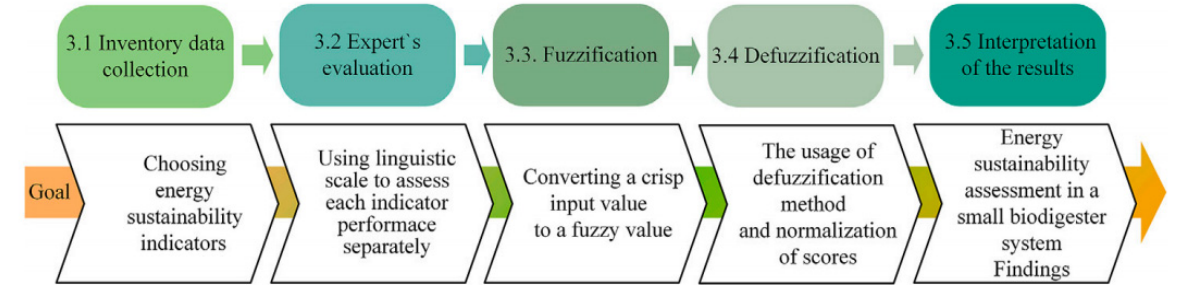
Figure 2. A schematic framework for energy sustainability (impact) assessment based on expert knowledge. Source: Kluczek and Gladysz